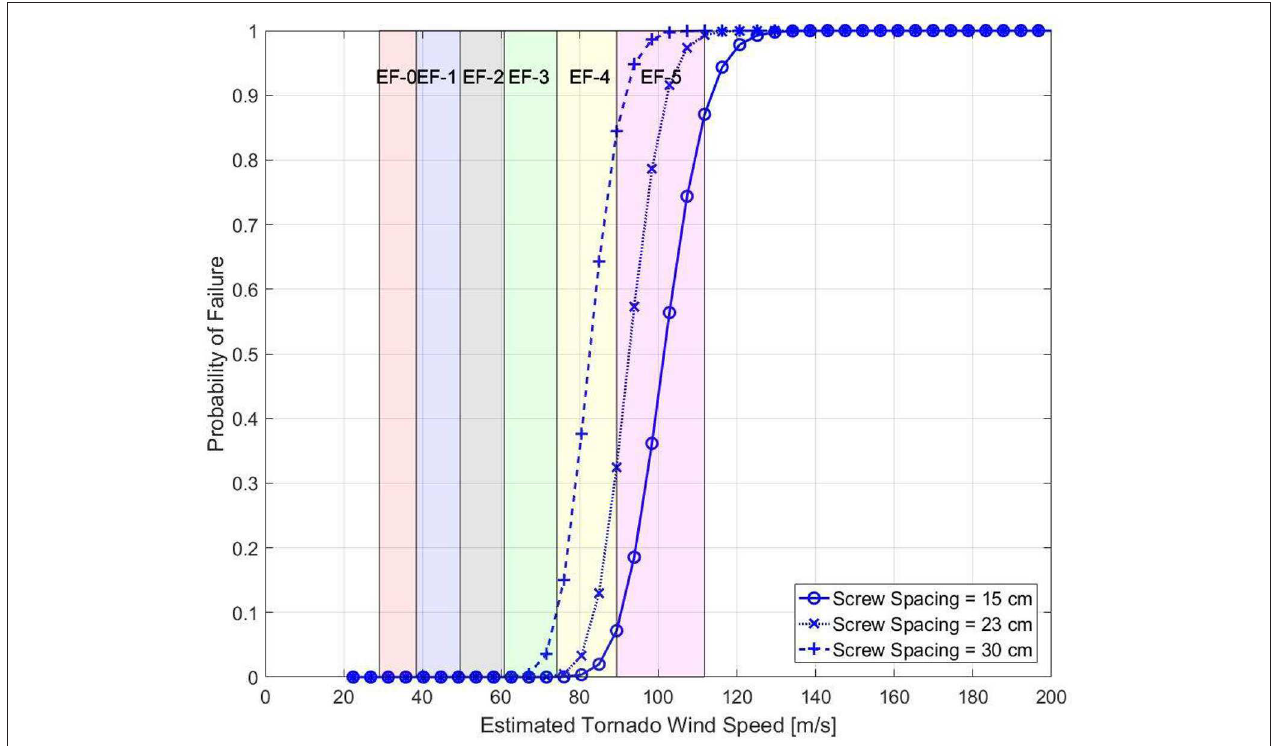
FIGURE 9 | Variation in performance based on change in spacing of screw connections for structure